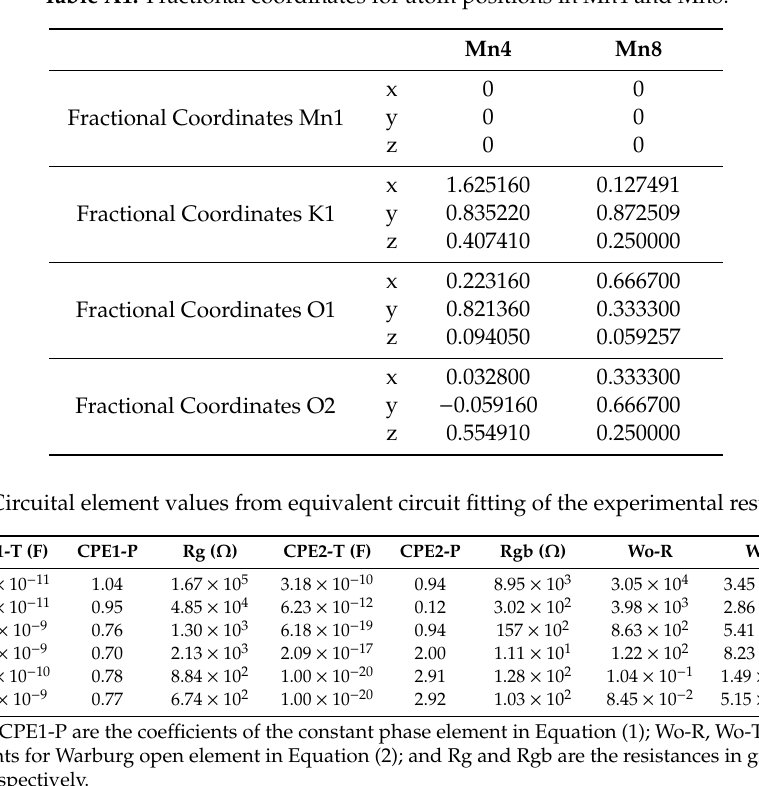
Table A1. Fractional coordinates for atom positions in Mn4 and Mn8.